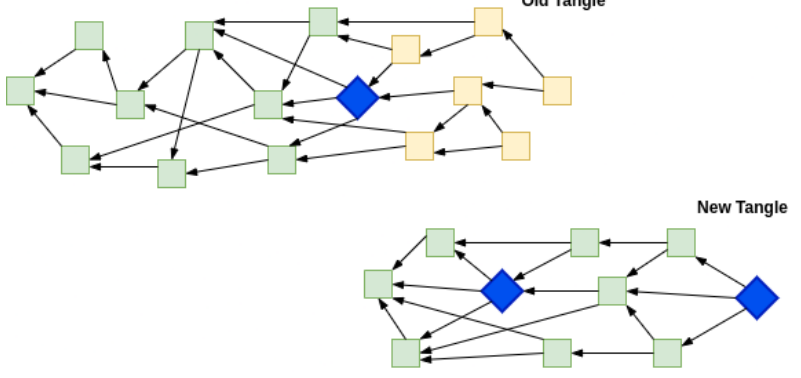
Figure 8. Tangle splitting virtually into